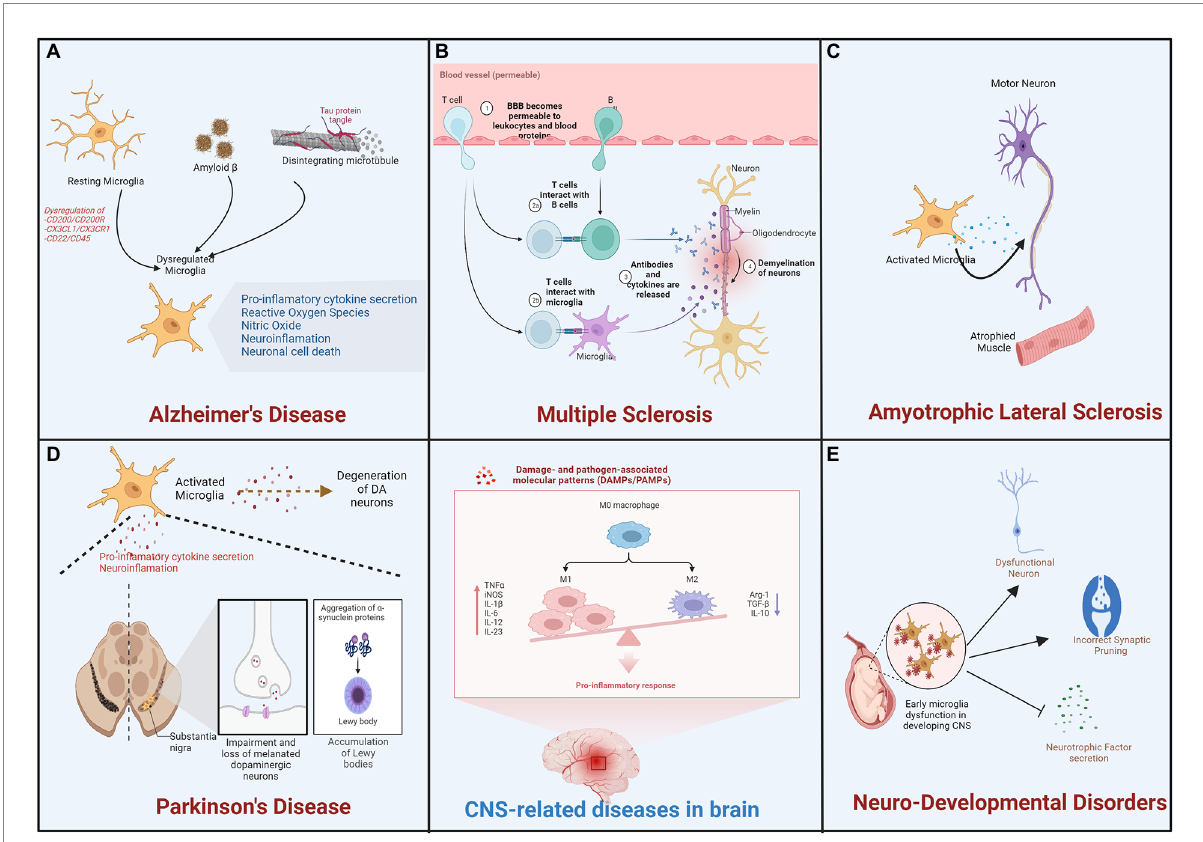
FIGURE 3 Microglial activation is involved in the progression of neurodevelopmental and degenerative diseases. During pathological processes, alternation in microglial function and activation process is involved in neurodegenerative diseases such as (A) Alzheimer’s disease (AD), (B) Multiple Sclerosis (MS), (C) Amyotrophic Lateral Sclerosis (ALS), and (D) Parkinson’s Disease (PD) as well as (E) neurodevelopmental